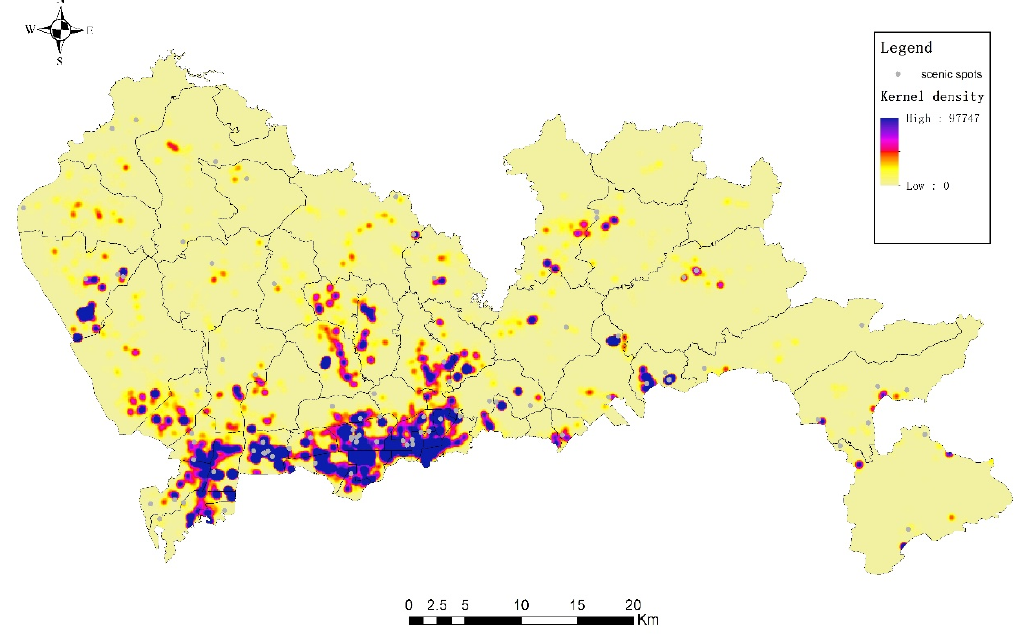
Figure 4. Kernel density of activity locations of users who visited tourist attractions. ISPRS Int. J. Geo-Inf. 2016 , 5 , 210